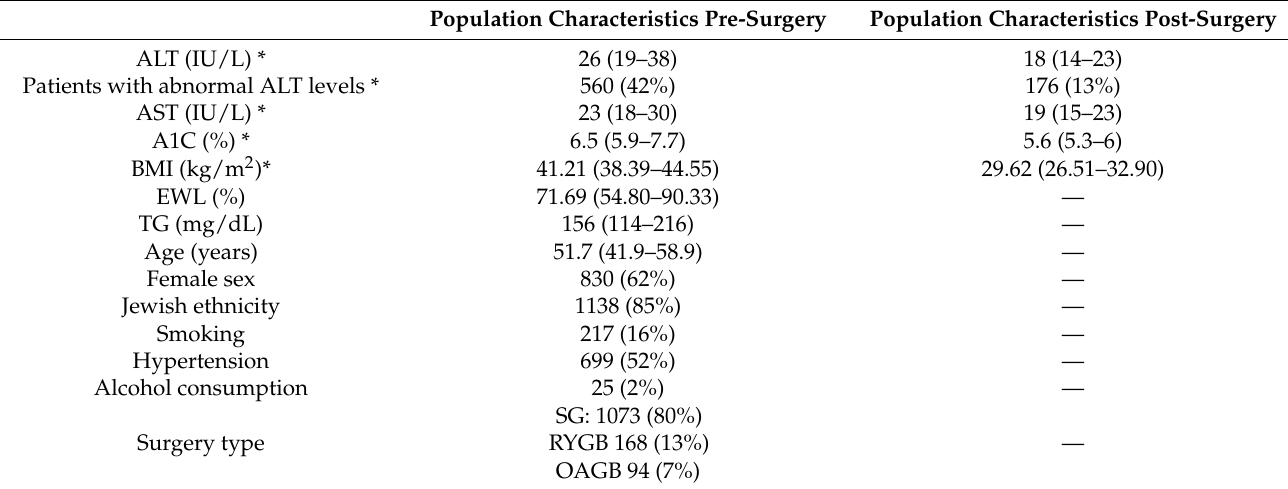
Table 1. Characteristics of patients in the registry with two-year follow-up data. Population Characteristics